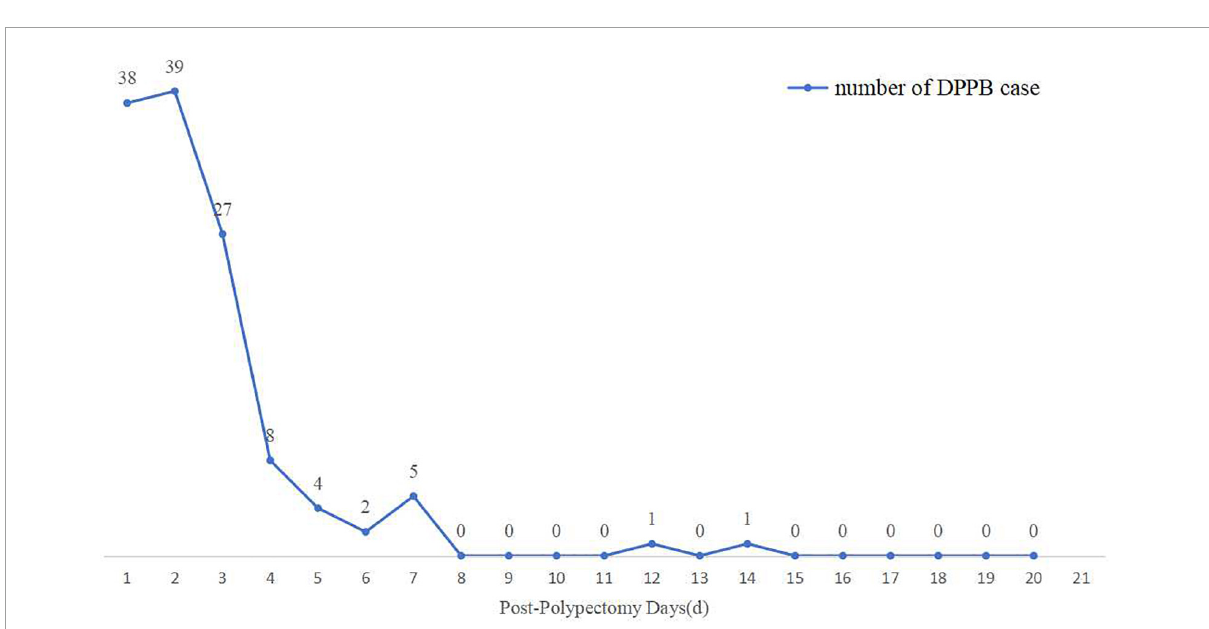
FIGURE7 The number of cases of delayed post-polypectomy bleeding (DPPB) and the time interval between completion of polypectomy and occurrence of